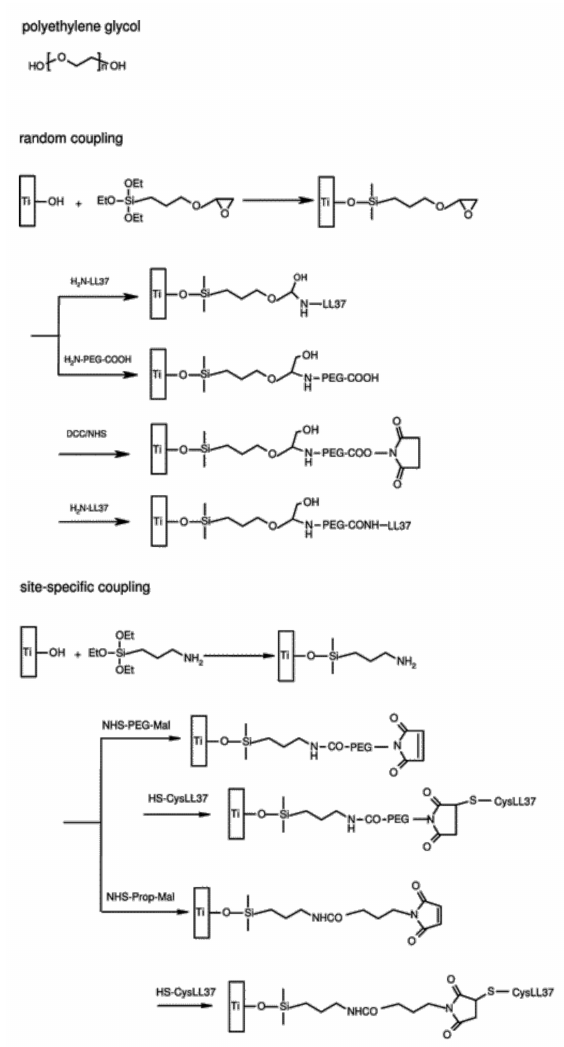
Figure 4. Reaction schemes of AMP conjugation following random and site specific coupling methods with or without a spacer introduction onto silanized titanium. Adapted with permission from reference